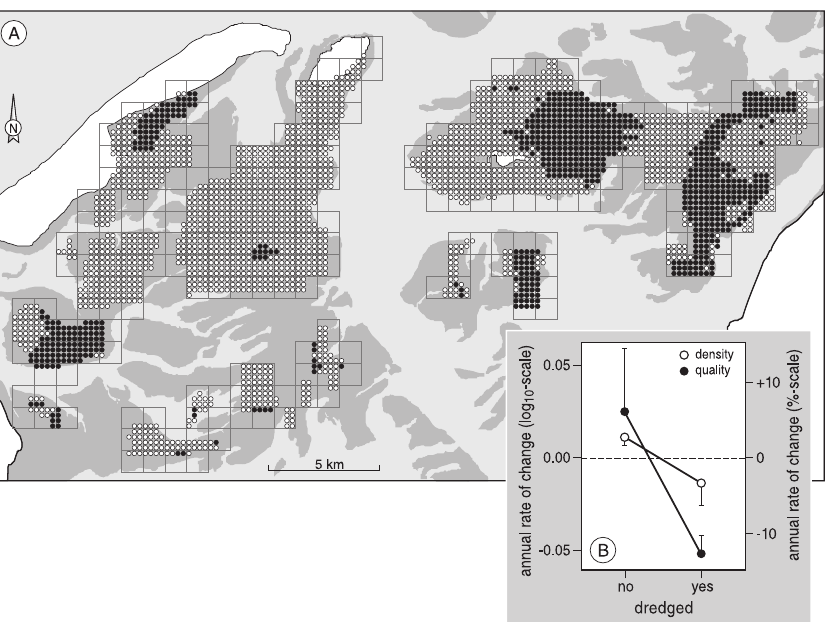
Figure 2. Study Area and Effects of Dredging (A) Map of the study area with 2,846 sampling stations (dots) categorized into 272 square kilometer blocks (squares containing 16 stations at most). A dot is filled when a station has been dredged at least once in 1998–2002 and is open when the station was never dredged during that period. (B) Densities of available cockles remained stable in dredged blocks, but they increased ( þ 3% y (cid:3) 1 ) in undredged blocks (open dots 6 SE bars). Quality of available cockles declined in dredged areas ( (cid:3) 11% y (cid:3) 1 ), whereas it remained stable in undredged areas (filled dots 6 SE bars). DOI: